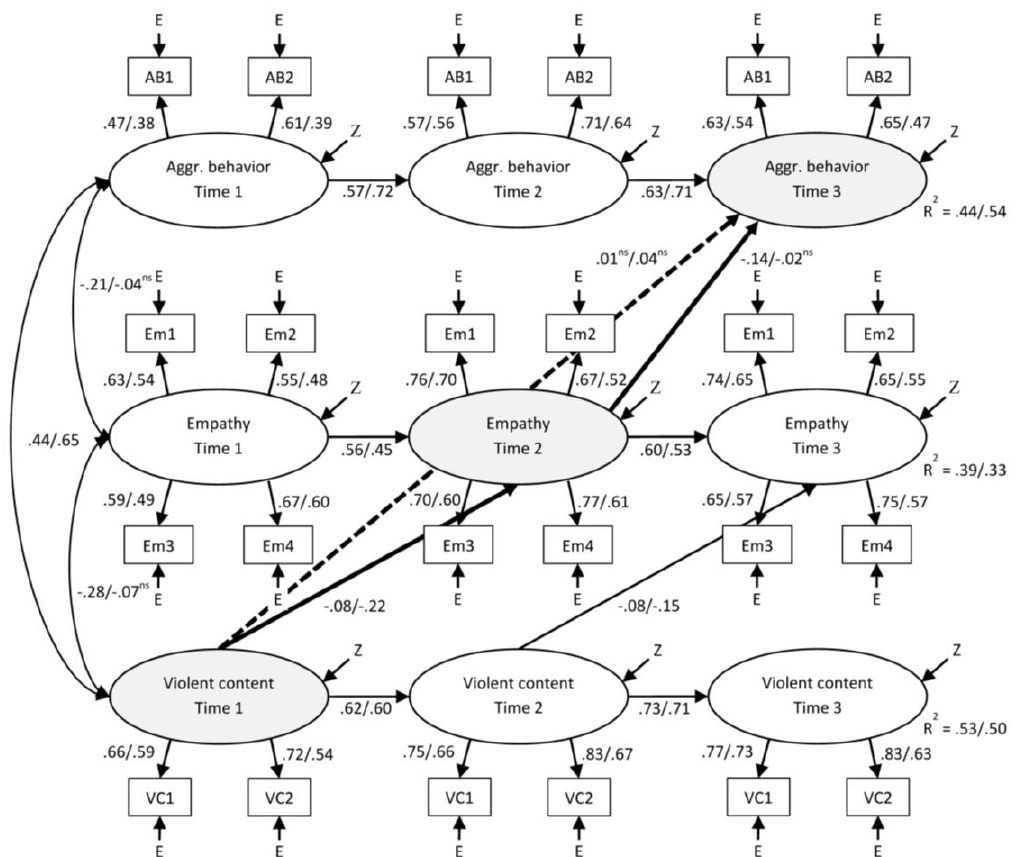
Figure 2. Observed mediation model of empathy, violent content consumption and aggressive behavior by gender